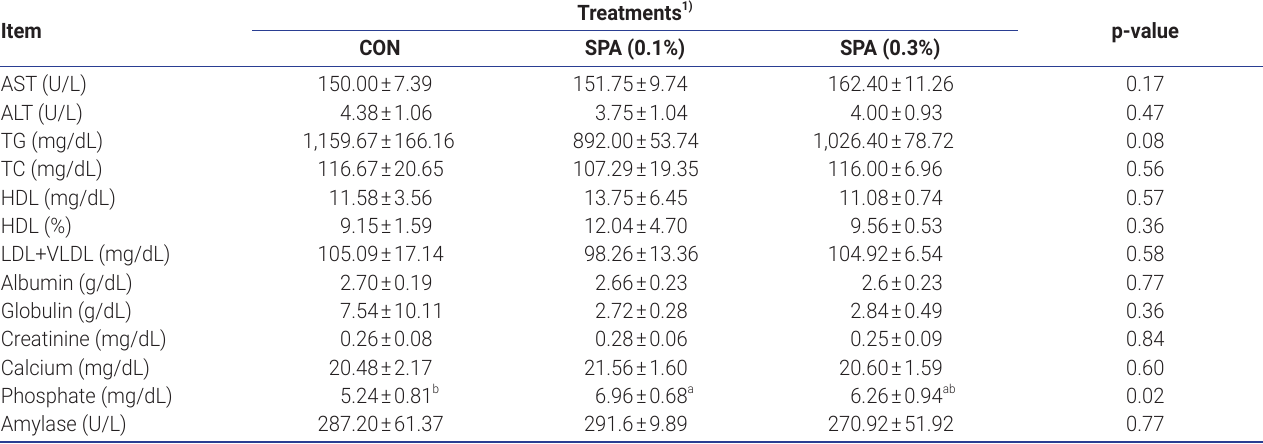
Table 5. Effect of supplementary SPA on blood characteristics in laying hens